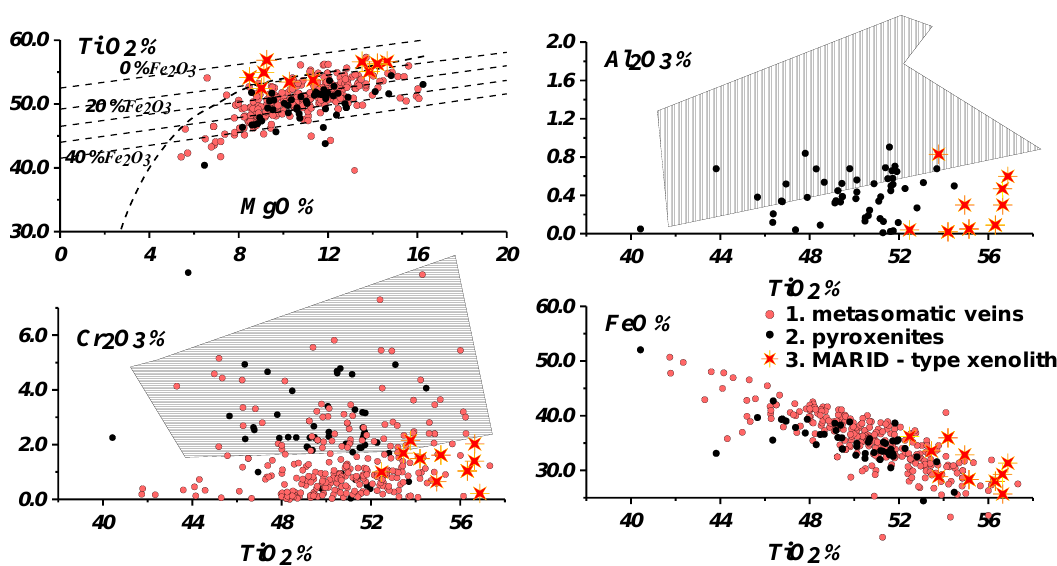
Figure 3. Variation diagram for ilmenite associations in xenoliths using data from literature and new analyses. 1. Ilmenites from metasomatic xenoliths; 2. from pyroxenites; 3. from MARID-type